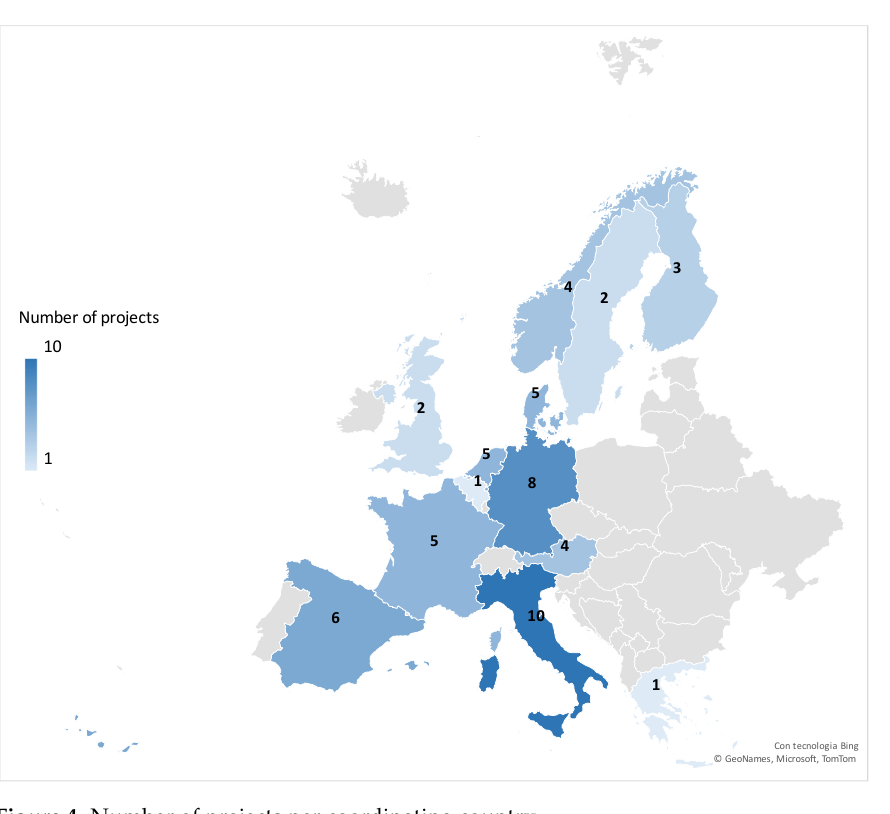
Figure 4. Number of projects per coordinating country.